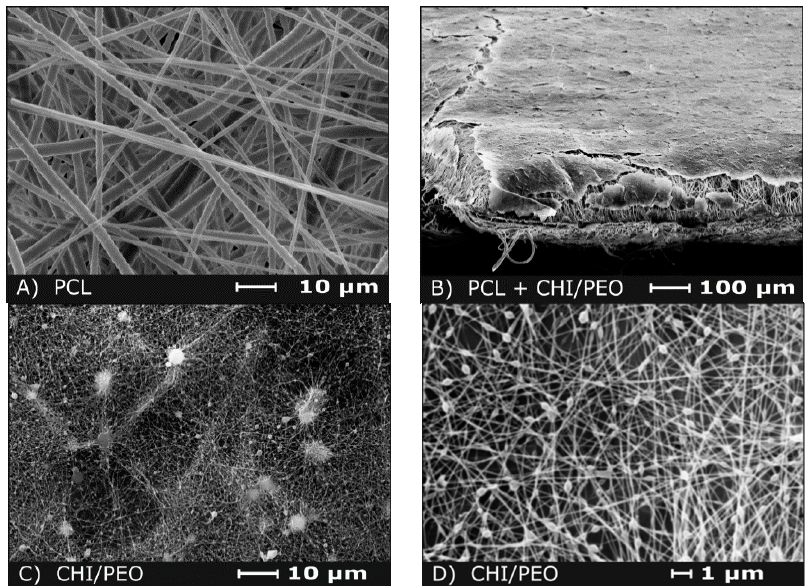
Figure 1. Aspect of the membranes analyzed by SEM. A ) polycaprolactone (PCL) dressing; B ) PCL dressing (larger fibers, bottom region) coated with the chitosan (CHI) / poly(ethylene oxide) (PEO) layer (shown as a thin membrane, top region); C and D ) Detail of the structure of the CHI / PEO layer with the bead-on-string morphology.